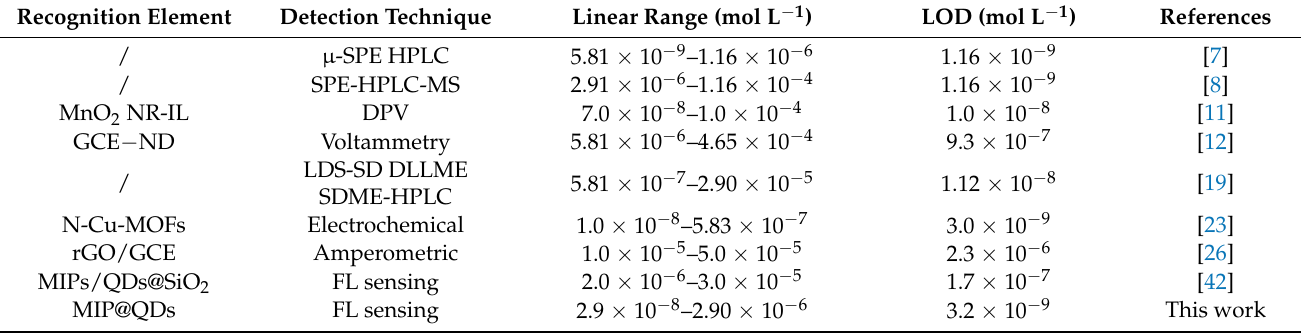
Table 2. Comparison of the performance of the MIP@QD-based sensor with previously reported analytical techniques for the determination of SAM.